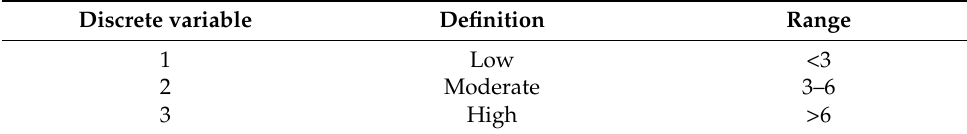
Table 7. Assignation to each category of rainfall erodibility factor.